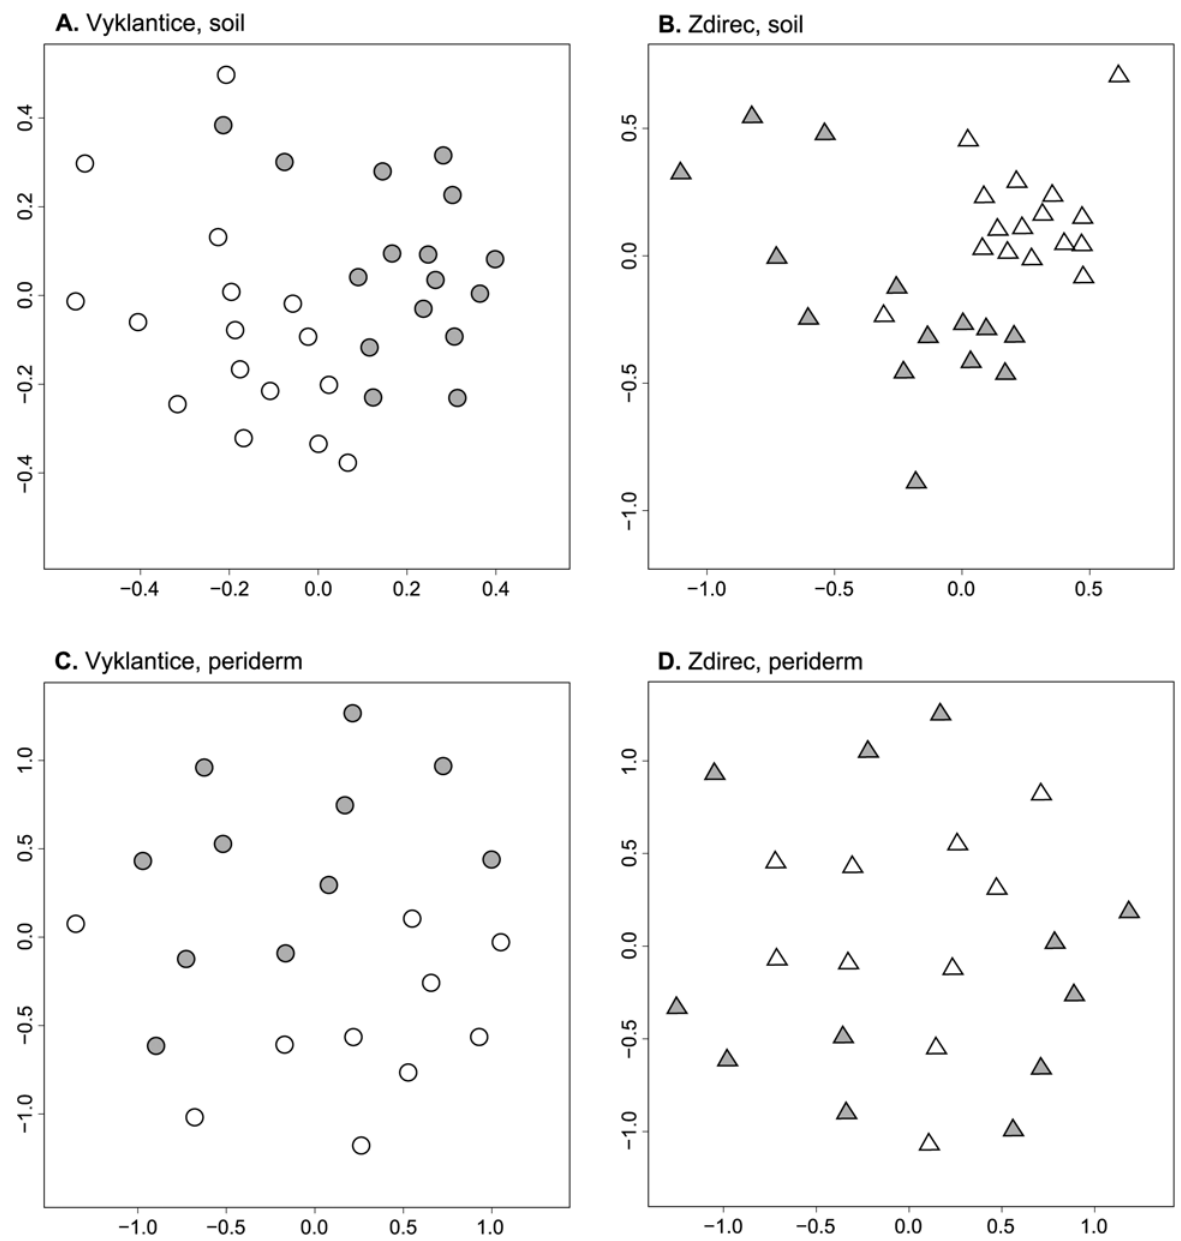
Figure 1. T-RFLP profiles of the communities of actinobacteria sampled at Vyklantice and Zdirec experimental sites from tuberosphere soil (A,B) and potato periderm (C,D). Sammon ’ s multidimensional scaling was based on Manhattan distance matrices calculated for the baseline filtered and normalized T-RFLP profiles. The symbols represent the profiles of actinobacteria at the fields with low (open symbols) and high (closed symbols) common scab severity.